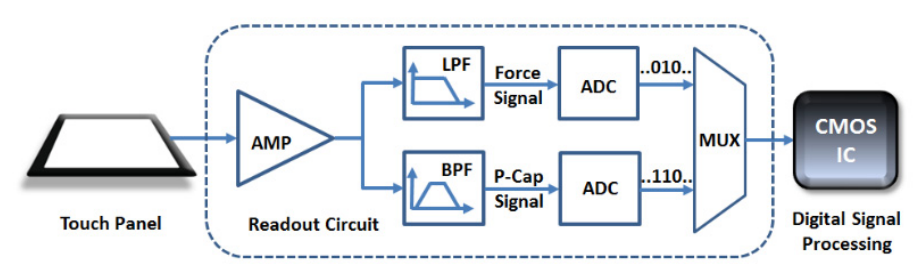
Figure 6. Block diagram of piezoelectric touch panel system [13] .